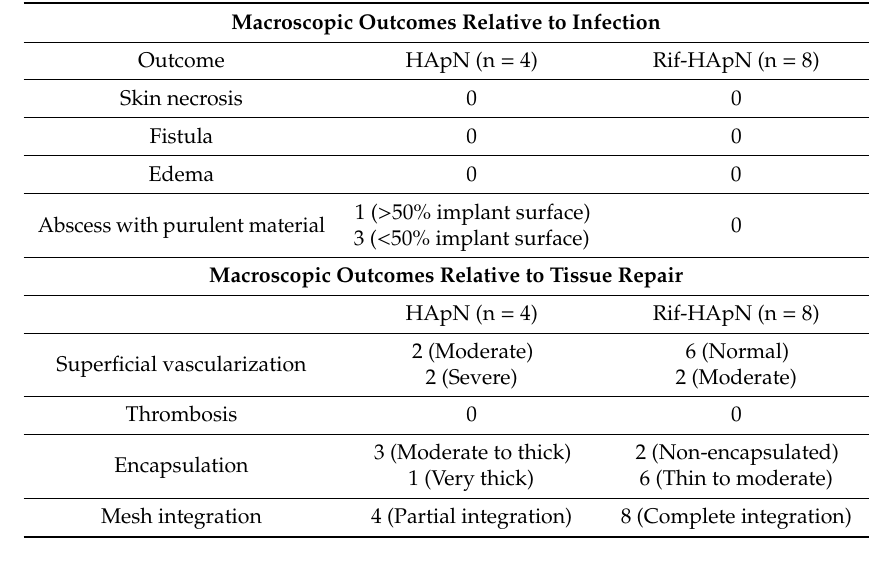
Table1. Macroscopicoutcomesofthedifferentimplants.Acompiledscoringisprovided, summarizingthe most relevant macroscopic outcomes from each study group at